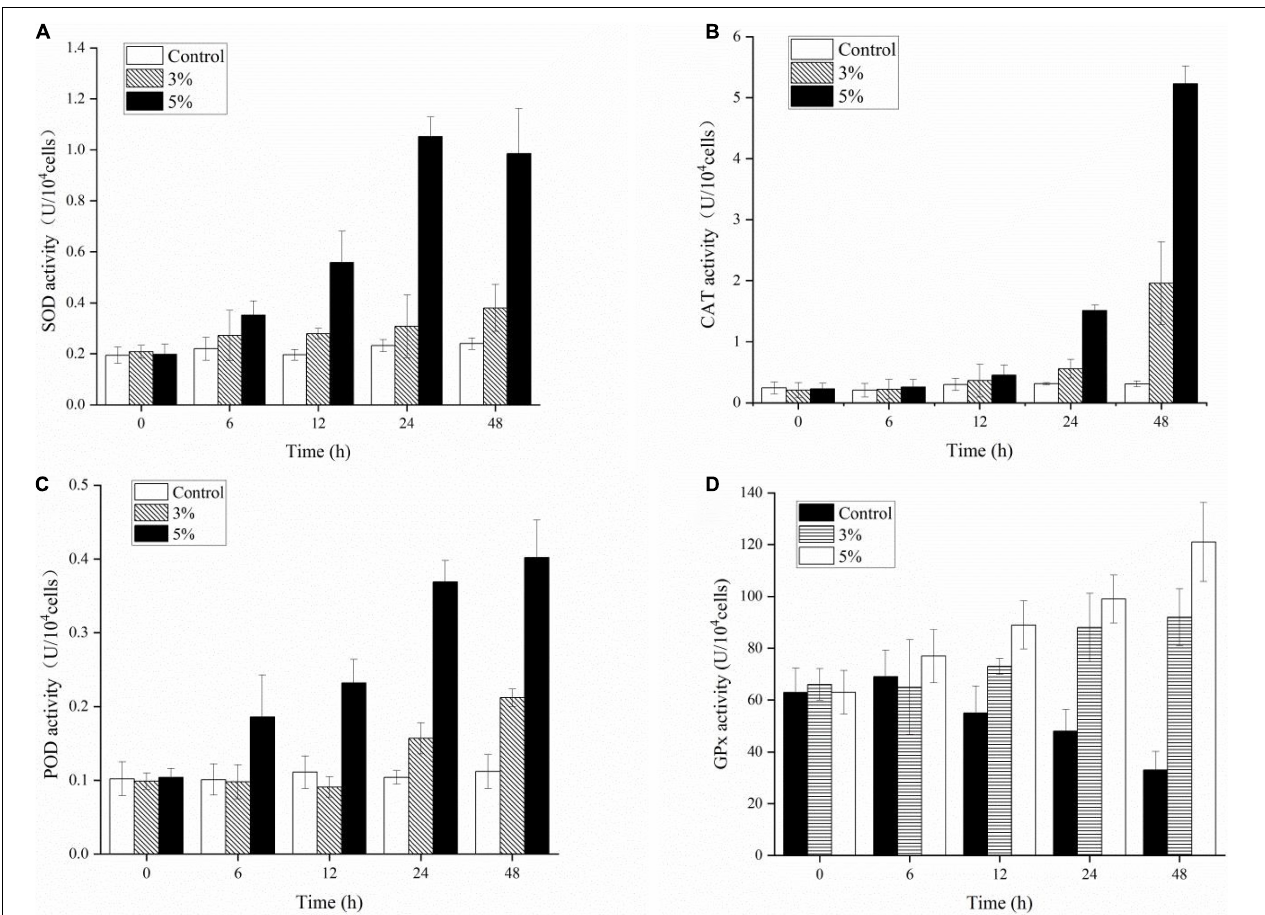
FIGURE 7 | Effects of enzymic antioxidants including SOD (A) , CAT (B) , POD (C) , and GPx (D) activities in Karenia mikimotoi after exposure to varying levels of Paracoccus homiensis